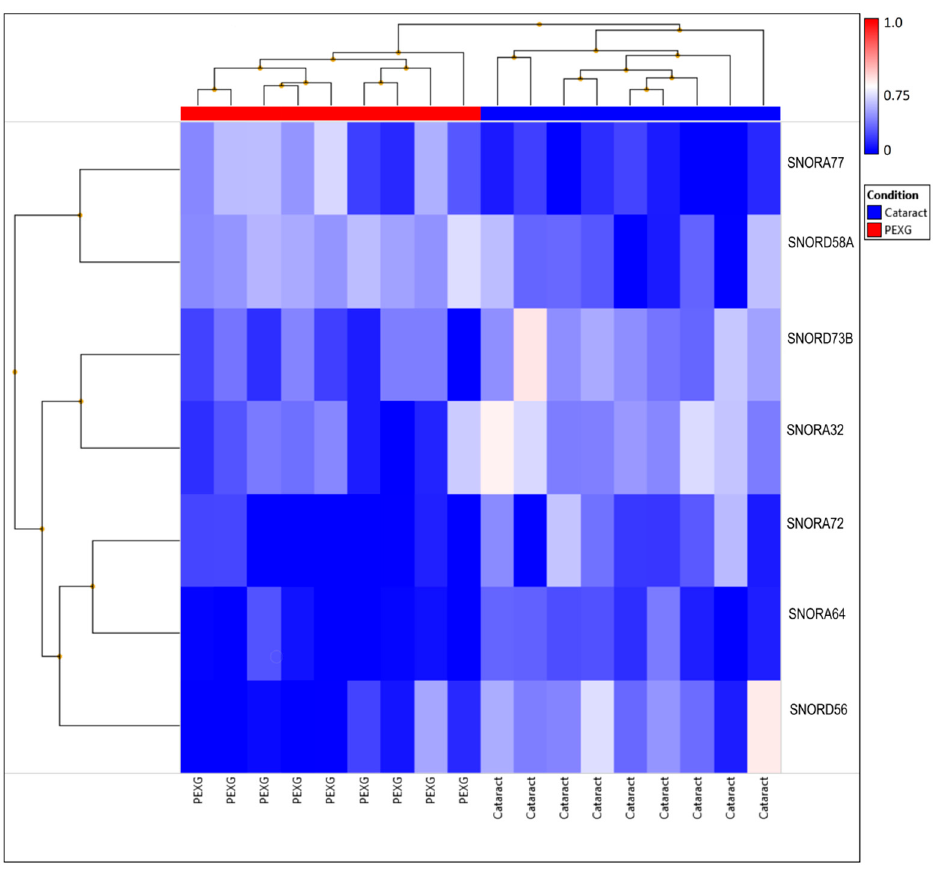
Figure 3. Cluster analysis results based on the expression levels of the detected snoRNAs.